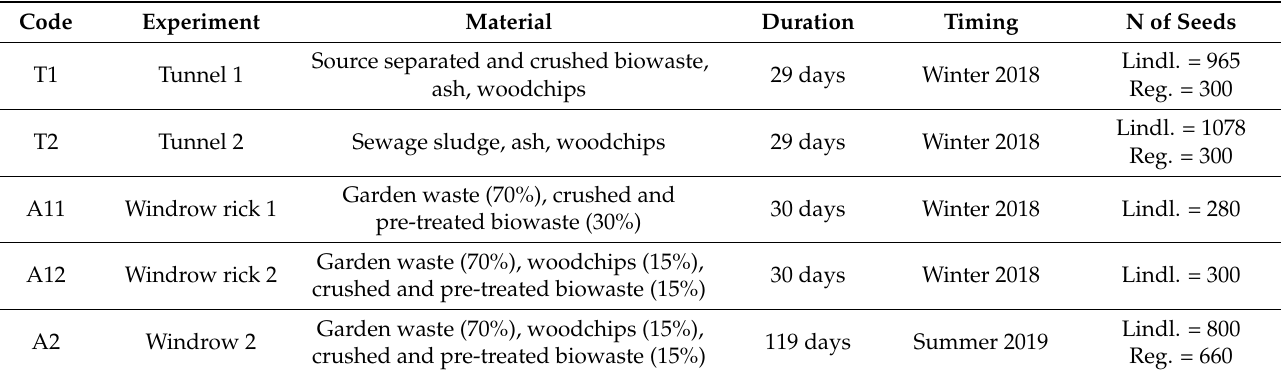
Table 1. Details of composting experiments. Lindl. refers to L. p. Lindley and Reg. to Russel